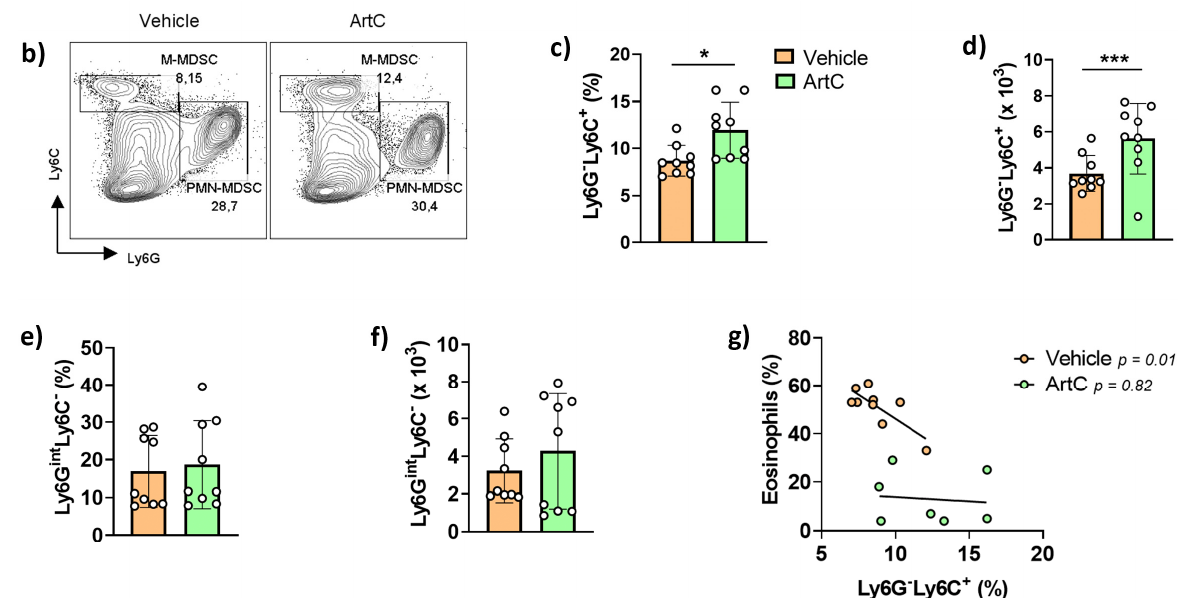
Figure 5. ArtC induces M-MDSC in the lungs of mice exposed to the allergen. ( a ) Gate strategy for Ly6G − Ly6C + (M-MDSC) and Ly6G + Ly6C int (PMN-MDSC) characterization in vivo; ( b ) representative dot plot of Ly6G − Ly6C + and Ly6G + Ly6C int in the lungs of mice exposed to the allergen treated with or not (Vehicle) with ArtC; ( c ) frequency, and ( d ) absolute number of Ly6G − Ly6C + in the lungs; ( e ) frequency, and ( f ) absolute number of Ly6G + Ly6C int in the lungs; ( g ) correlation between BALF eosinophils and lung Ly6G − Ly6C+. Data are representative of two independent experiments (n = 4–5/group/experiment) and expressed by mean ± SD. * p < 0.05 and *** p < 0.001.